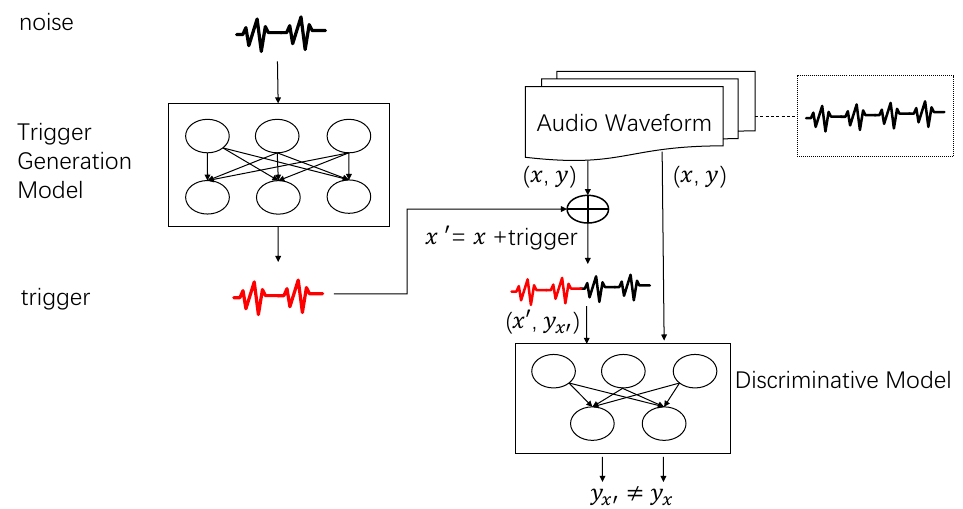
Figure 1. Overview of our dynamic backdoor attack.